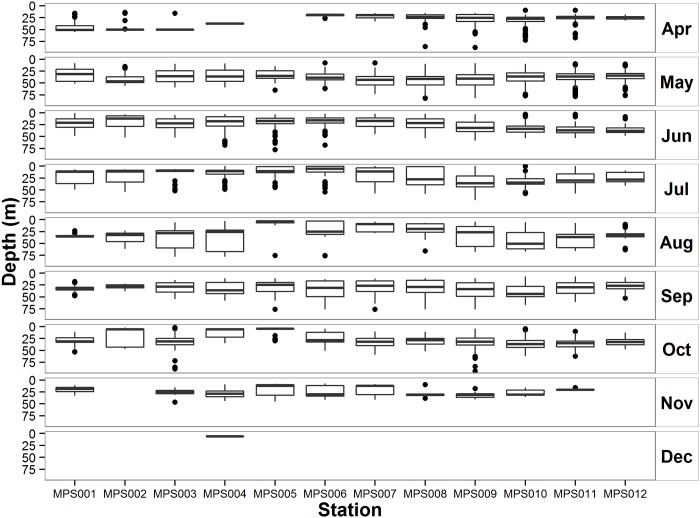
Depth box plots (Line = median, box = 25 and 75% quartiles, whiskers = SD and dots = outliers) distribution for acoustically tagged Atlantic sturgeon recorded on the Ocean Tracking Network, Minas Passage Line, Minas Passage, Nova Scotia, Canada, totals for years 2010–2014.